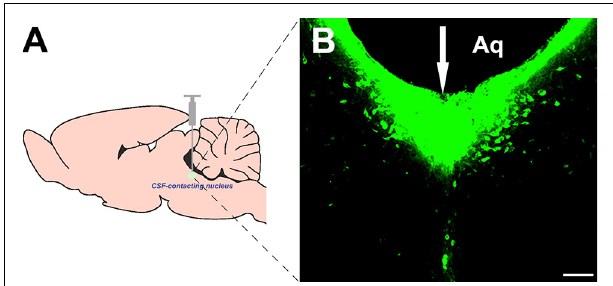
FIGURE 1 | Injection site of cholera toxin subunit B (CB) into the cerebrospinal fluid (CSF)-contacting nucleus (A,B) . White arrow ( ↓ ): site of the CB injection. Aq, aqueduct. Bar = 100 µ